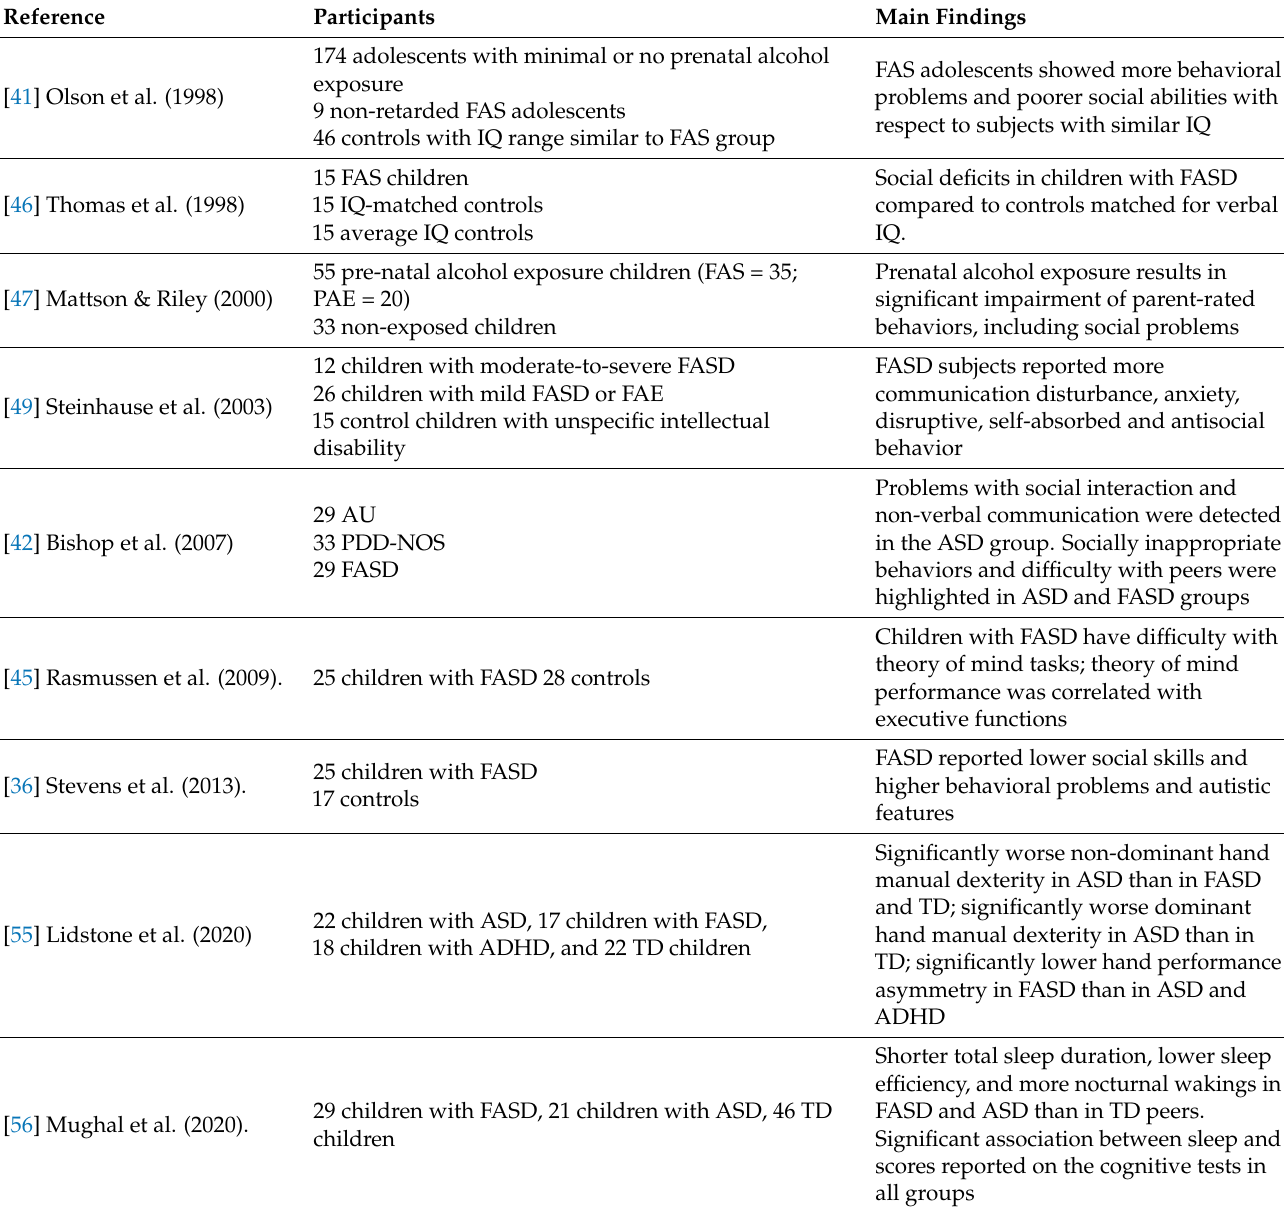
Table 3. Similarities between FASD and ASD